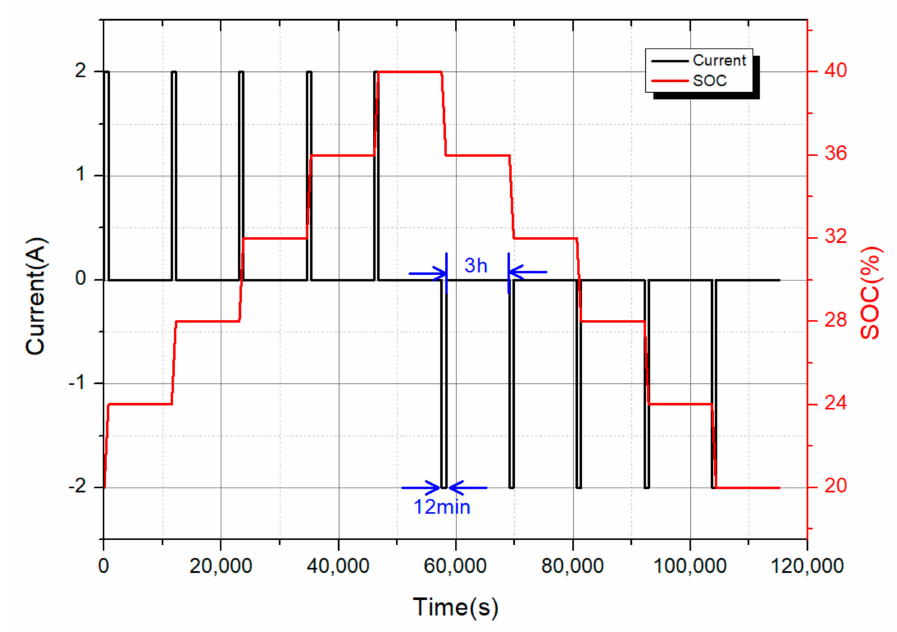
Figure 8. Pulse currents used for the minor loop hysteresis